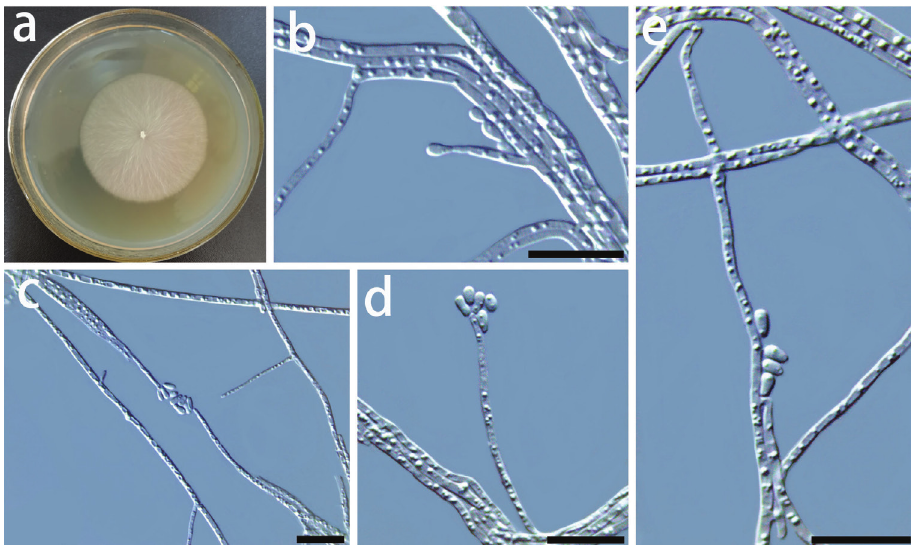
Figure 10. Morphological characters of asexual structures of Ceratocystiopsis weihaiensis sp. nov a four- teen-day-old culture on MEA b-e conidiophores and conidia. – Scale bars: 10 µm.